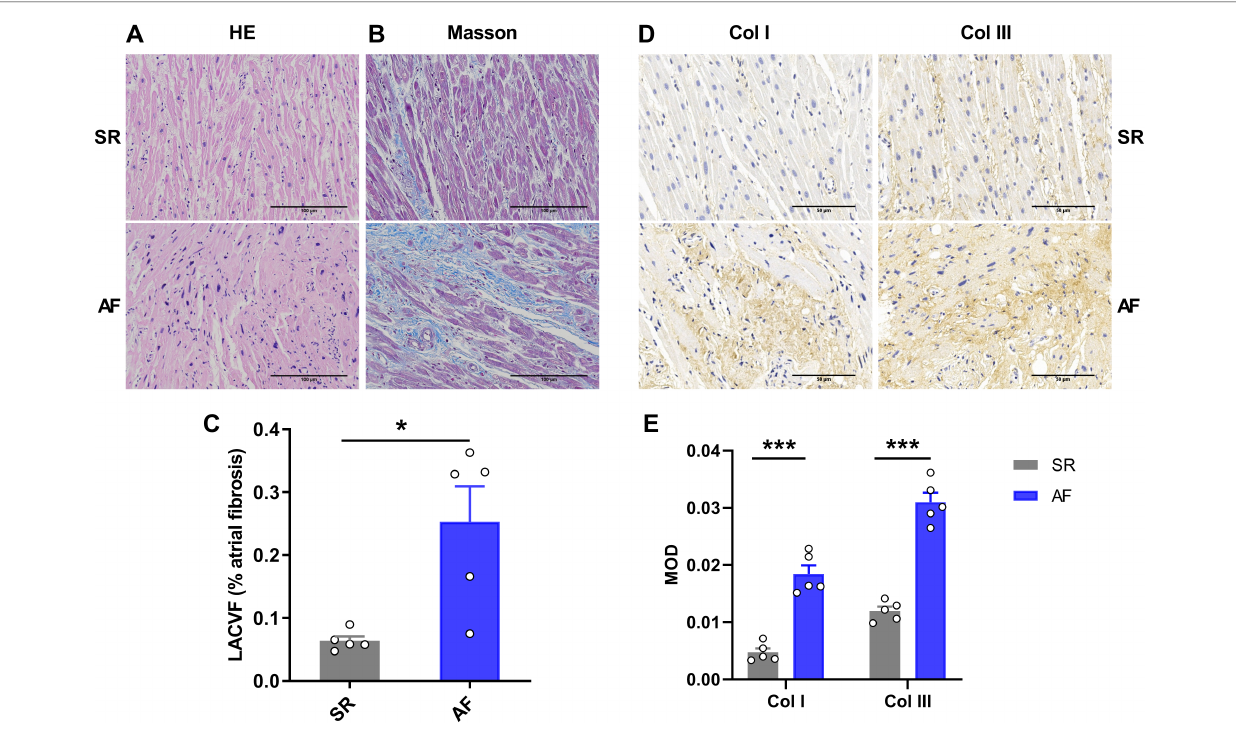
FIGURE 2 Atrial fi brosis occurs in patients with atrial fi brillation. ( A ) HE staining of LAA tissue in the SR and AF groups. ( B ) Masson ’ s Trichrome staining in the two groups. ( C ) Comparison of left atrial collagen volume fraction between the SR and AF groups. ( D,E ) Immunohistochemistry staining and comparison of collagen I and III between the SR and AF groups. SR, sinus rhythm. AF, atrial fi brillation. Col I, collagen I; Col III, collagen III. * p <0.05 and *** p <0.001 compared to the SR